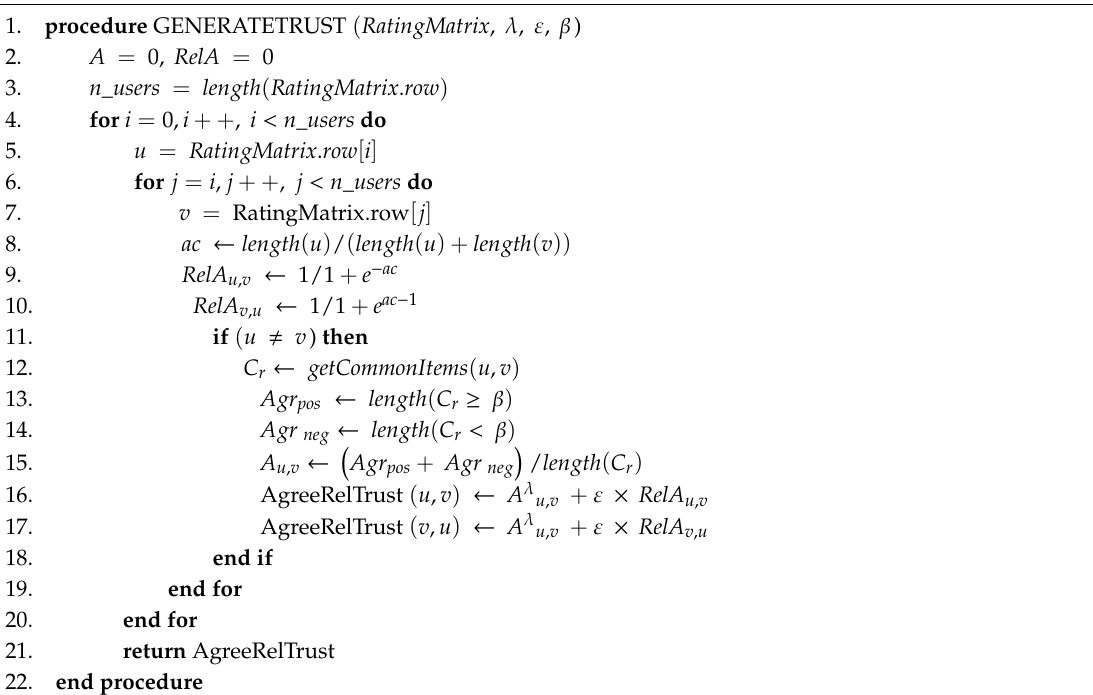
Algorithm 1. Pseudocode for calculating the AgreeRelTrust